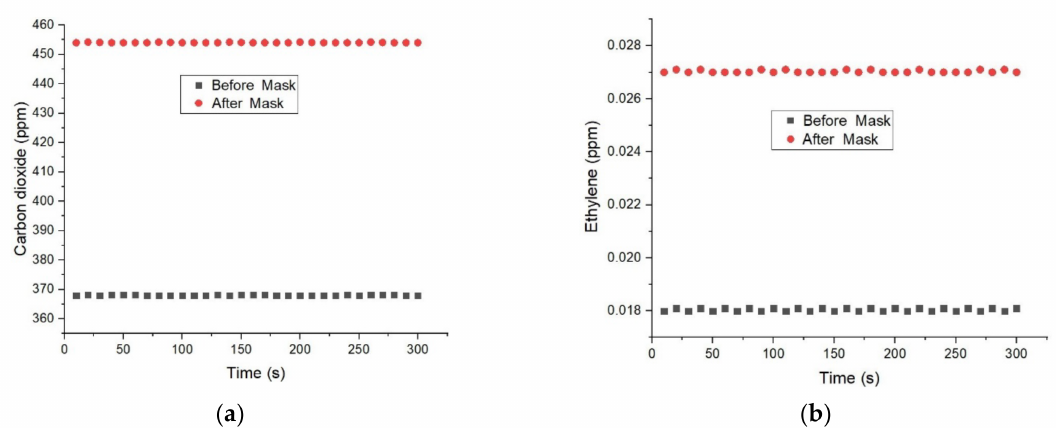
Figure 3. ( a ) Concentrations of CO 2 measured before and after one hour of for surgical face mask wearing ( b ) Concentrations of ethylene measured before and after one hour of for surgical face mask wearing.